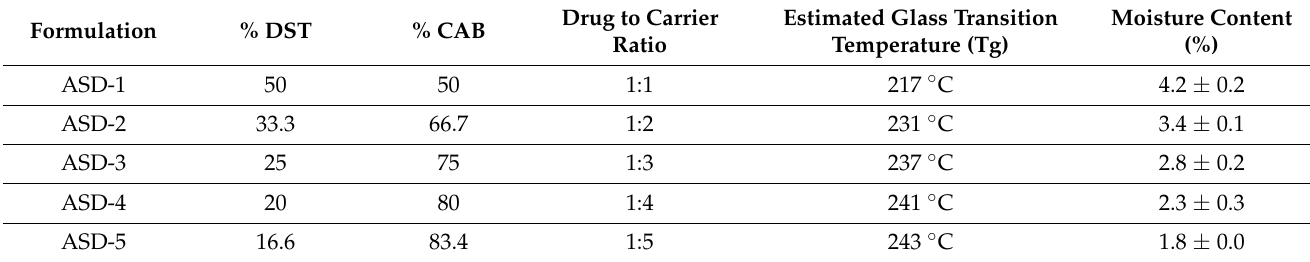
Table 1. Composition of